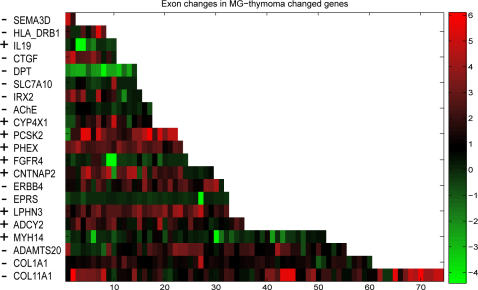
MG-thymoma targeted genes identified as subject to major changes in MG-thymoma tumors by specific, term-to-parent, ad-hoc combined statistical analyses and ACHE.The color scale (right) presents fold changes (log base 2), and each core exonic probe set is presented as a single band. The strand of each gene is denoted (as+for forward or-for reverse). The exons are ordered from 5′ to 3′ for genes on the+strand and from 3′ to 5′ for genes on the-strand, such as ACHE. Note that most transcripts show mixed patterns of changes (both increases and decreases), reflecting alternative splicing.